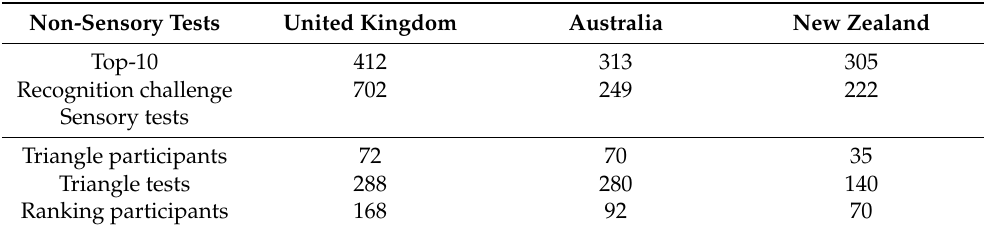
Table 1. Number of participants and sensory tests carried out within this research in three differ- ent